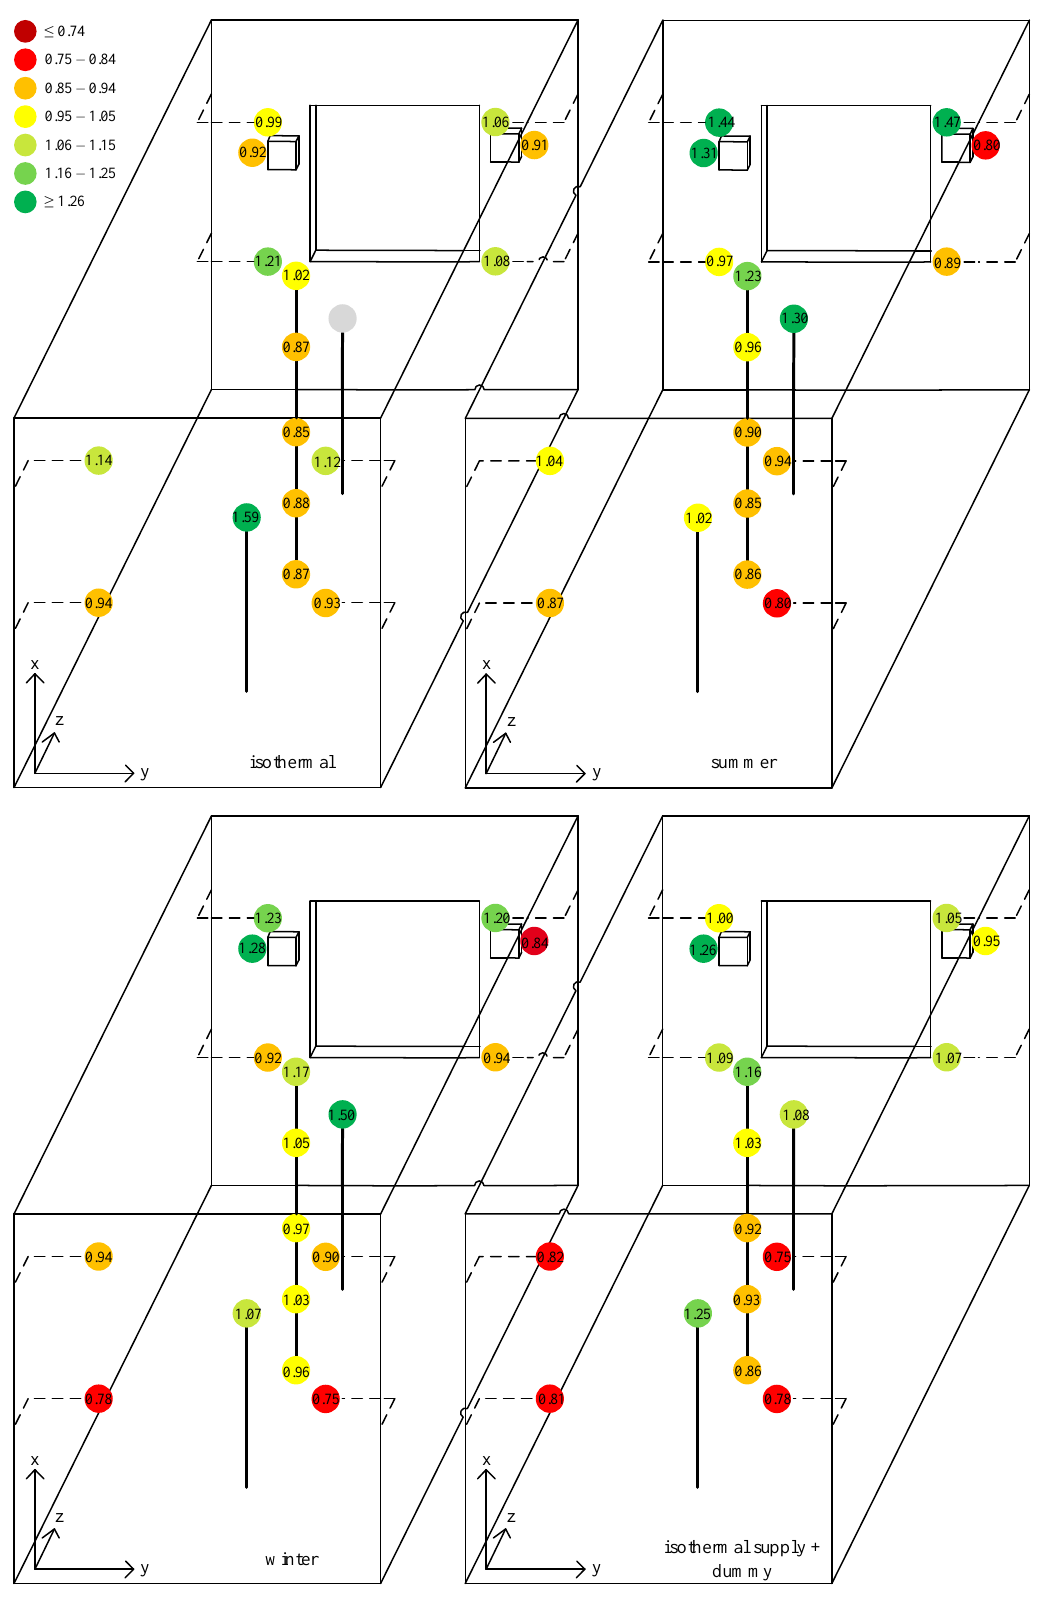
Figure 7. Local air exchange indices ε a (2–3) at V = 28 m 3 · h − 1 : isothermal ( top left ), summer ( top right ), winter supply air conditions ( bottom left ), isothermal supply air conditions plus placement of a dummy to simulate human heat dissipation of 300 W ( bottom right ) [36].